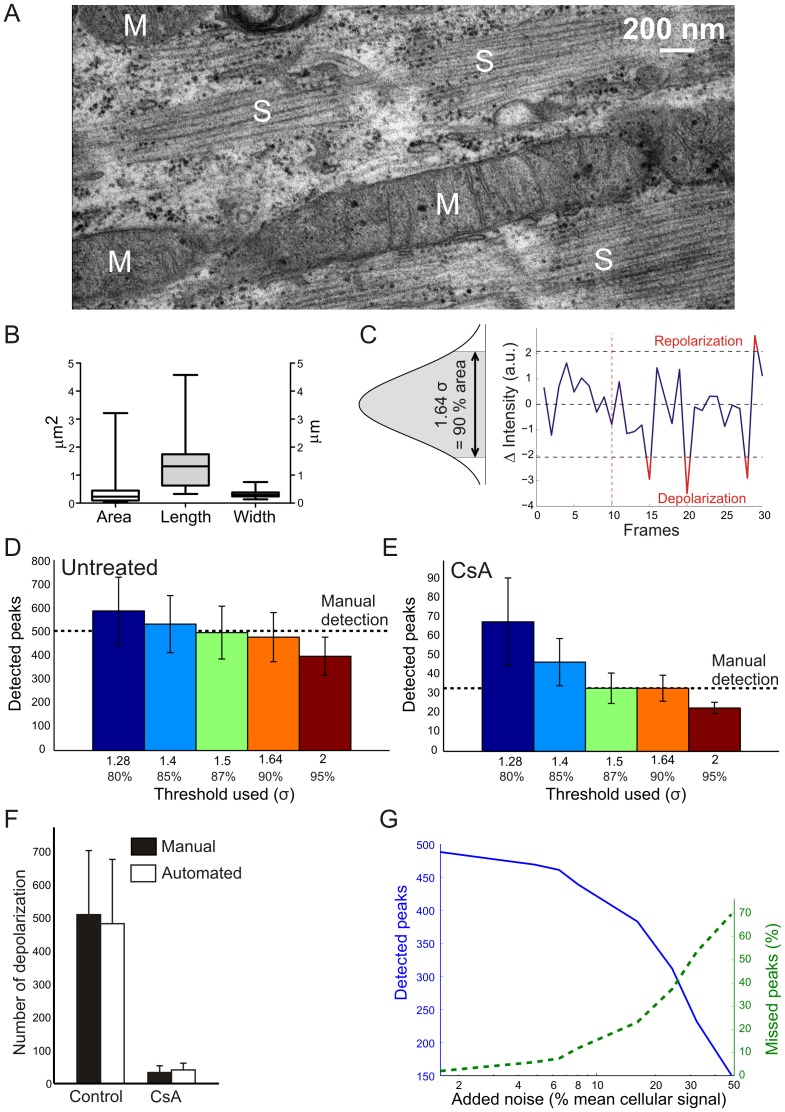
Optimization and validation of the automated algorithm for spatiotemporal analysis of ΔΨ flickering.(A) Transmission electron microscopy (TEM) picture of mitochondria in primary mouse myotubes. M indicates mitochondria and S indicates sarcomeres. (B) Box and whisker plot showing the median, minimum and maximum value, and the 1st and 3rd quartile of the mitochondrial (N = 31) area, length and width in myotubes based on TEM. (C) Process to define the threshold used to detect mitochondrial depolarizations and repolarizations. Different thresholds, 1.28 (80% certainty), 1.4 (85% certainty), 1.5 (87% certainty), 1.64 (90% certainty), and 2 (95.5% certainty) times σ, were used and their corresponding numbers of depolarizations were compared to manual analysis of untreated (D) and CsA-treated (E) myotubes. (F) The number of mitochondrial depolarizations detected by the optimized computer-assisted analysis are comparable to the manual analysis in control (N = 8 in 3 experimental replicates) and CsA-treated (N = 7 in 3 experimental replicates) myotubes. The CsA treatment led to a significant difference (p≤0.001) while manual and automated analysis cannot be distinguished statistically (p = 0.454) (G) Addition of noise to the movie to define the robustness of the computer-assisted analysis.